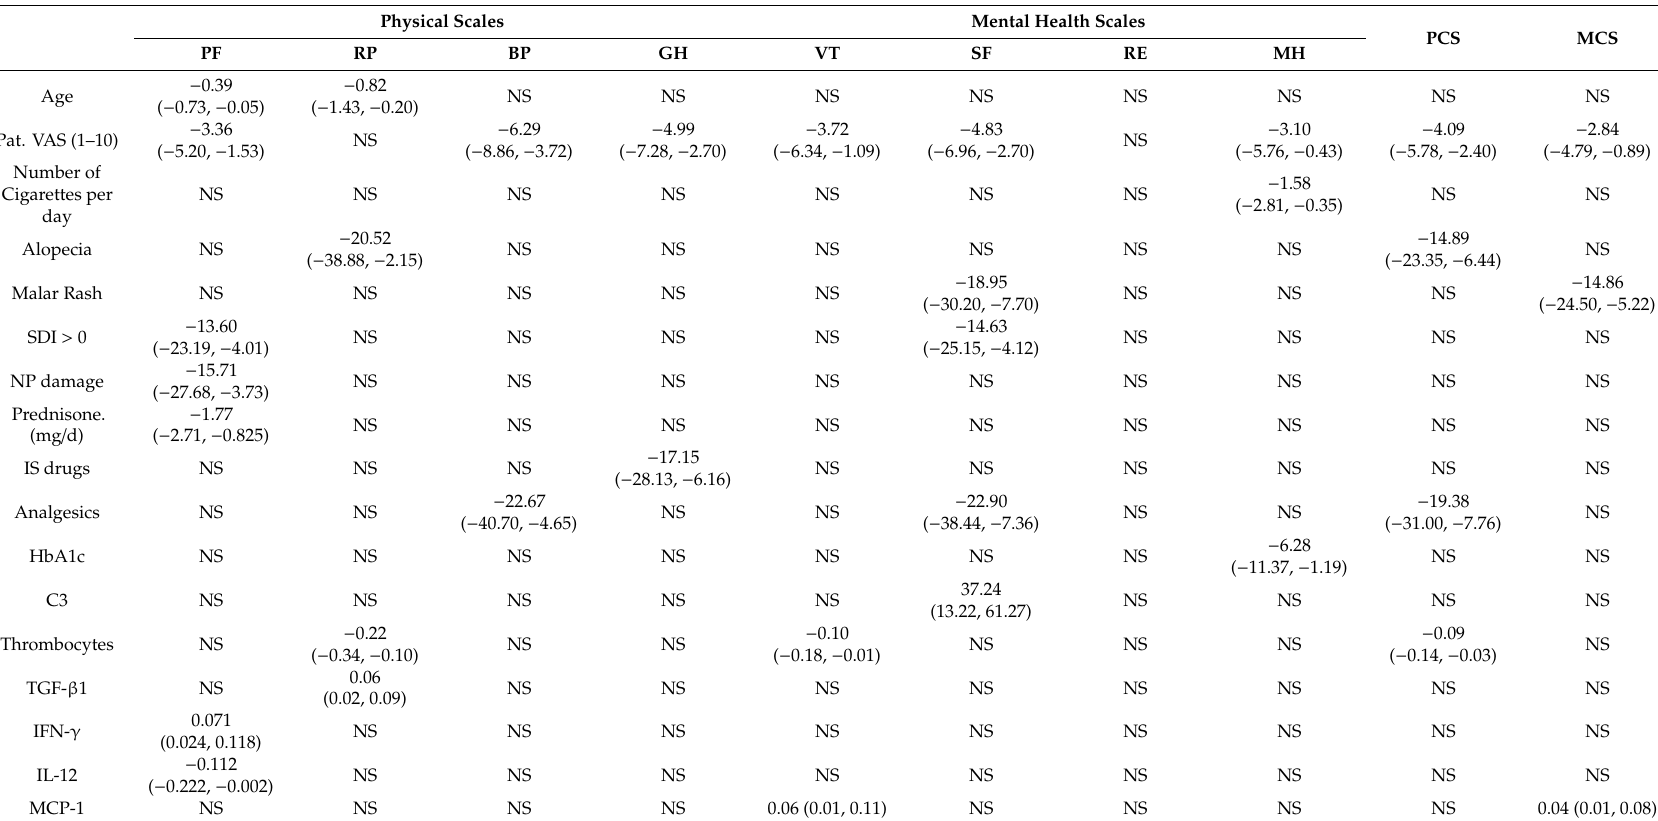
Table 4. Multiple linear regression model, assessing the e ff ect size (ES) of the significant univariate factors on the health-related quality of life, quantified with the Short Form 36 domain and summary